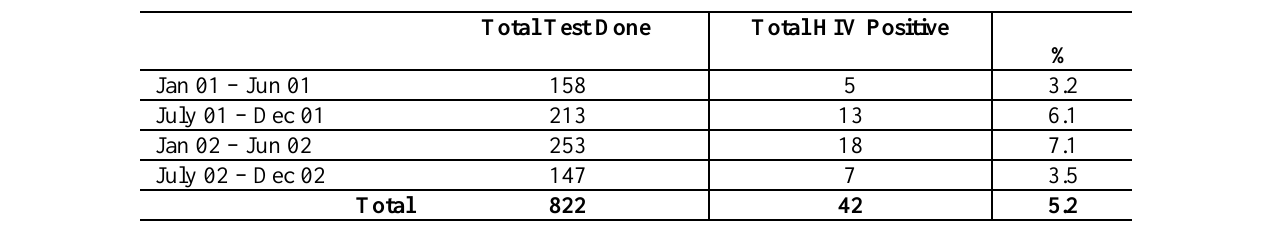
Table I : Results of HIV tests